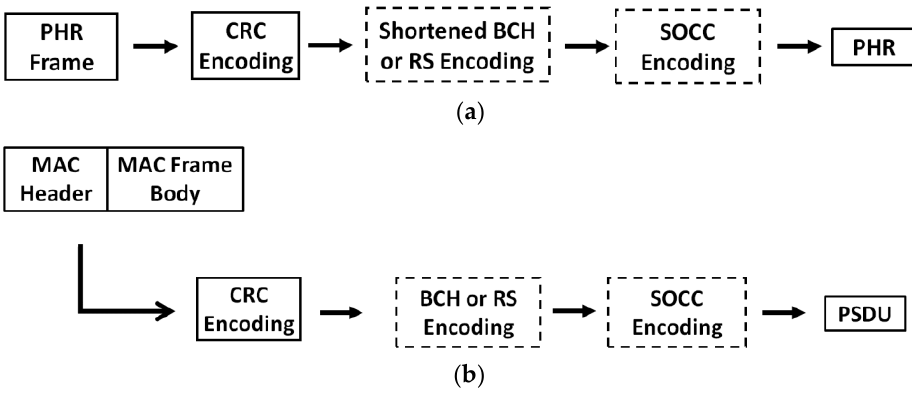
Figure 6. ( a ) PHR construction for transmission. ( b ) PSDU construction for transmission.